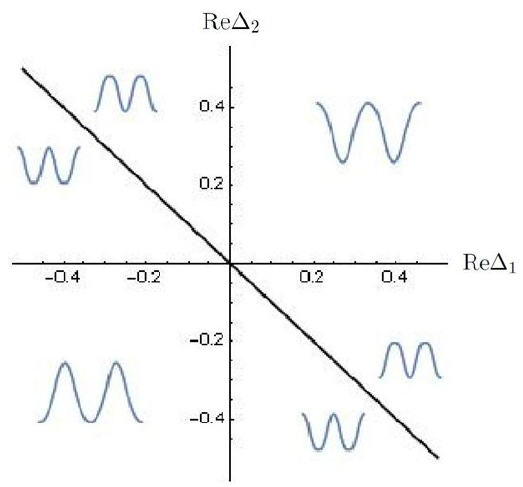
Figure 1 . The qualitative behavior of V Q ( x ; arg (cid:12); Re(cid:1) k ) as a function of x for (cid:12)xed Re(cid:1) 1 ; 2 and (cid:12)xed arg (cid:12) 2 ( (cid:0) (cid:25)= 2 ; 0), in various regions of the space of the control-parameters Re(cid:1) 1 ; 2 .